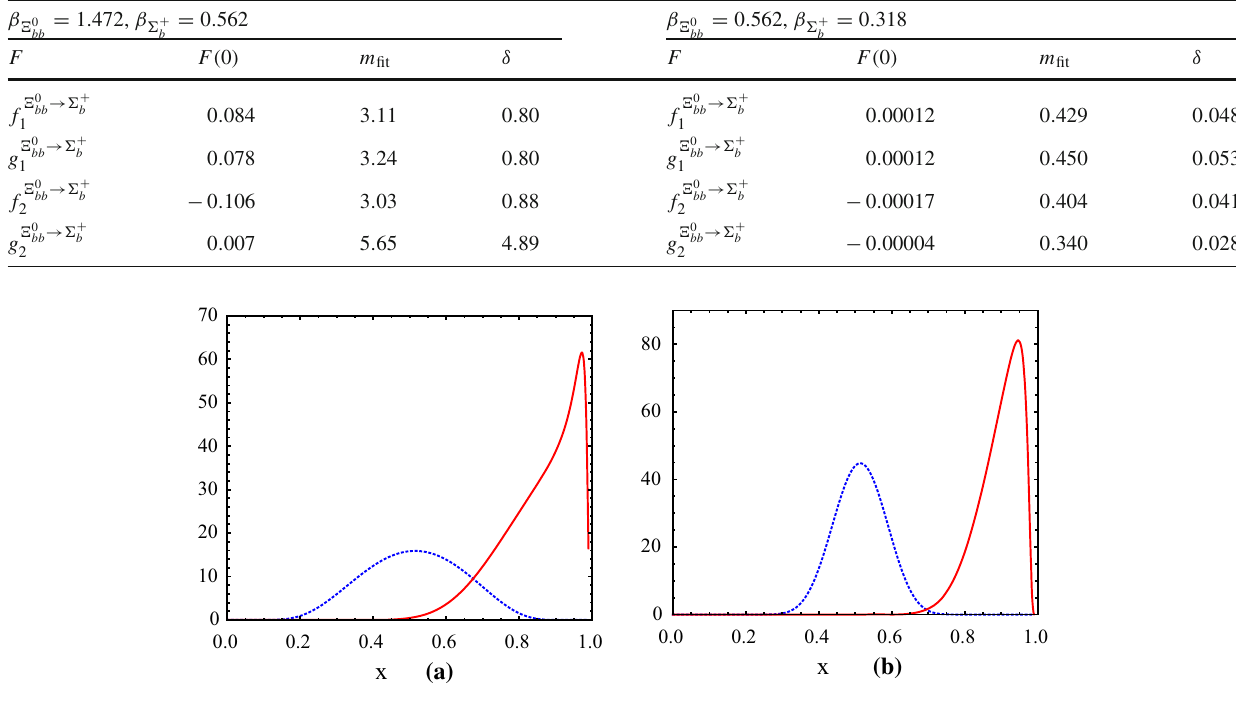
Fig. 3 Light-front wave functions for (cid:4) 0 (dotted curves) and (cid:6) + and (cid:6) + , and thus the left (right) panel lap of wave functions of (cid:4) 0 buu buu bbu bbu leads to a larger (smaller) form factors. When showing these results, we (solid curves). Here x is the momentum fraction. In the left panel, we = 1 . 472 GeV and β = 0 . 562 GeV; while in the = 0 . 1GeV 2 , and we have found similar results for other have used k 2 have used β (cid:4) 0 (cid:6) + T bbu buu = 0 . 562 GeV transverse momentum k right panel, the following parameters are used: β (cid:4) 0 bbu = 0 . 318 GeV. The form factor can be viewed as the over- and β (cid:6) + buu